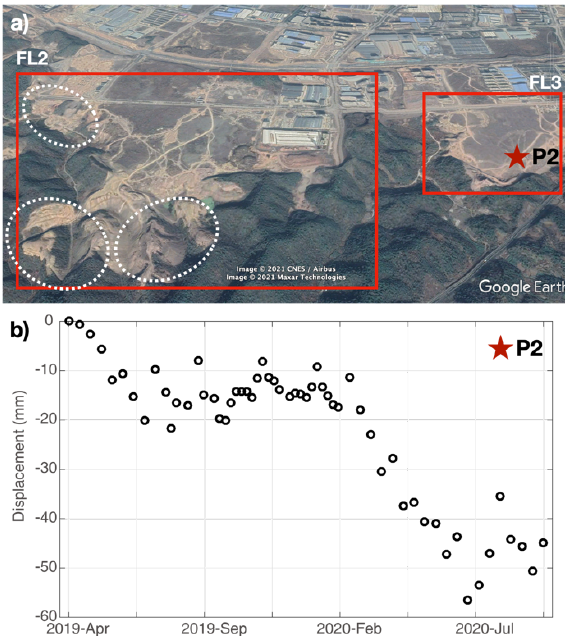
Figure 7 . (a) Google Earth TM images of FL2 and FL3. The white circles mark the deformed construction slopes. (b) Time- series displacement of P2 on the excavation slope.